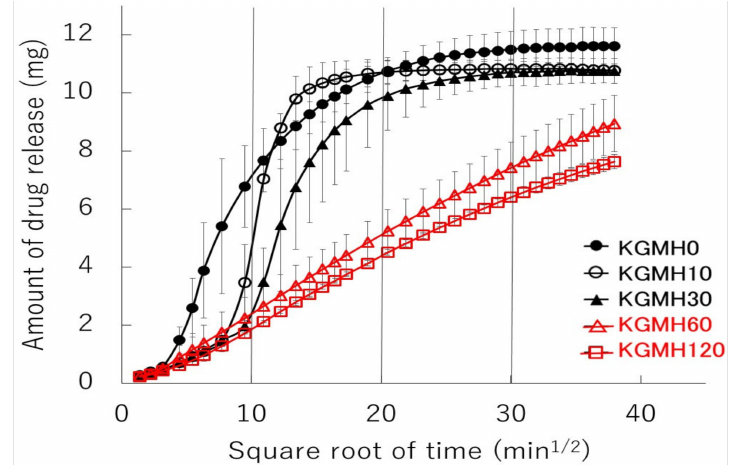
Figure 6. Higuchi-type plots of the amount of drug released from the KGMH matrix tablets against the square root of time.